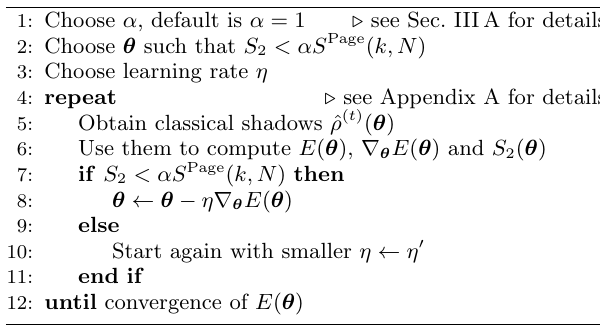
Algorithm 1. WBP-free optimization with classical